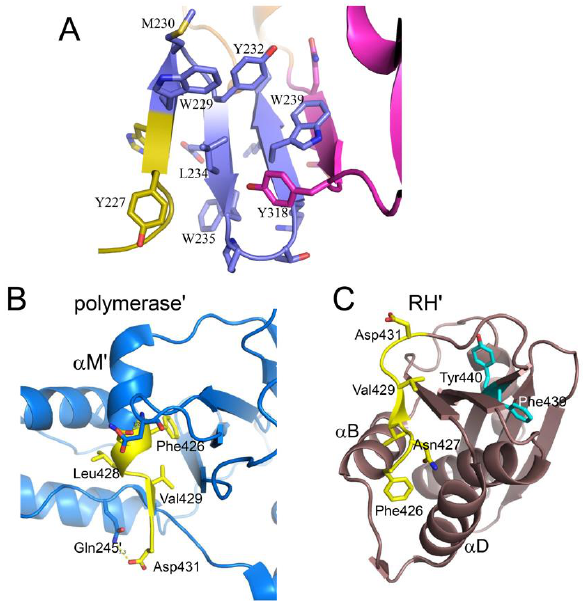
Figure 17. Structural features of HIV-2 RT. ( A ) Ribbon diagram showing the p66 subunit β -sheet in HIV-2 RT formed from palm and connection residues as part of the maturation process; color code: palm loop (gold); palm (blue); connection (magenta); ( B ) Ribbon diagram of the HIV-2 RT p51 subunit (blue) showing the residues Phe426–Phe439 that are also present in the RH domain in yellow; ( C ) Ribbon diagram of the HIV-2 RH domain (brown), with the residues from Phe426–Phe439 shown in yellow. These structural features suggest a maturation process for HIV-2 RT that is similar to the process described for HIV-1 RT.